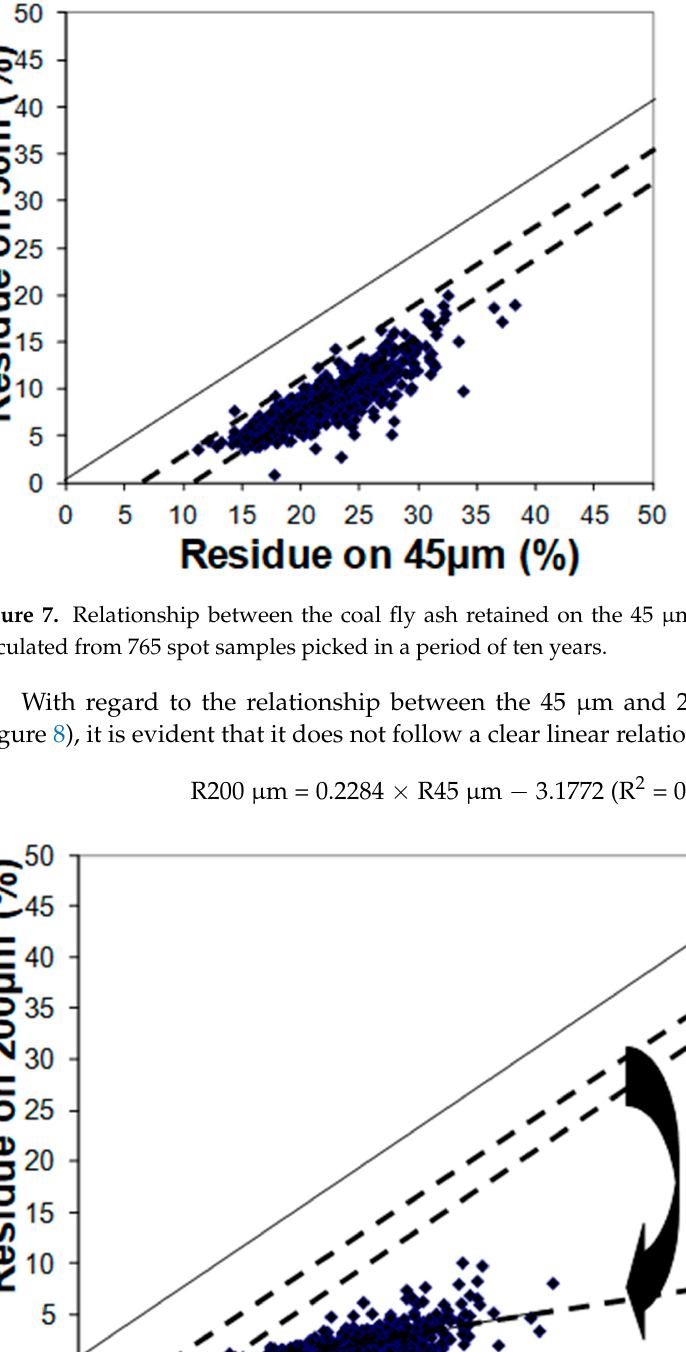
Figure 6. Relationship between the coal fly ash retained on the 45 µm and 63 µm sieves, calculated from 765 spot samples picked in a period of ten years.